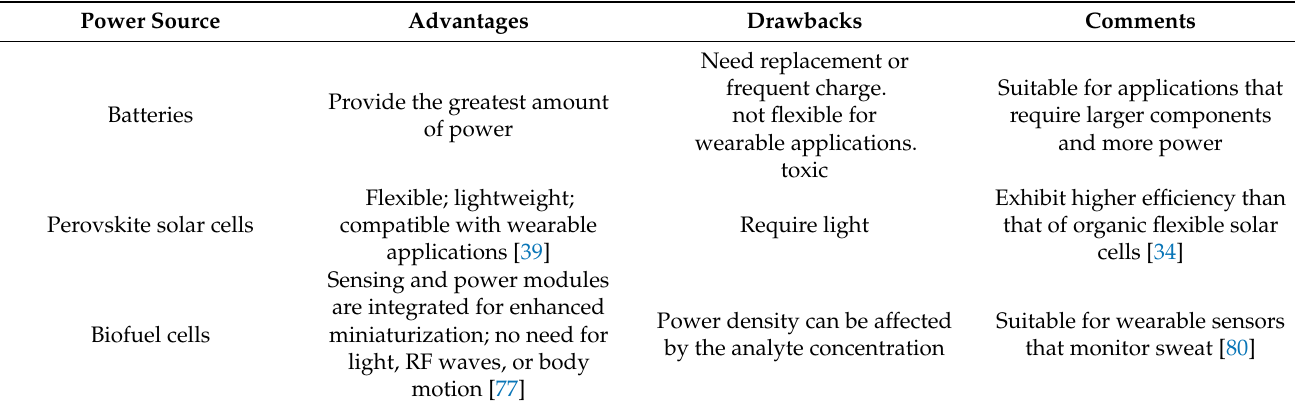
Table 11. Characteristics of various energy sources for wearable